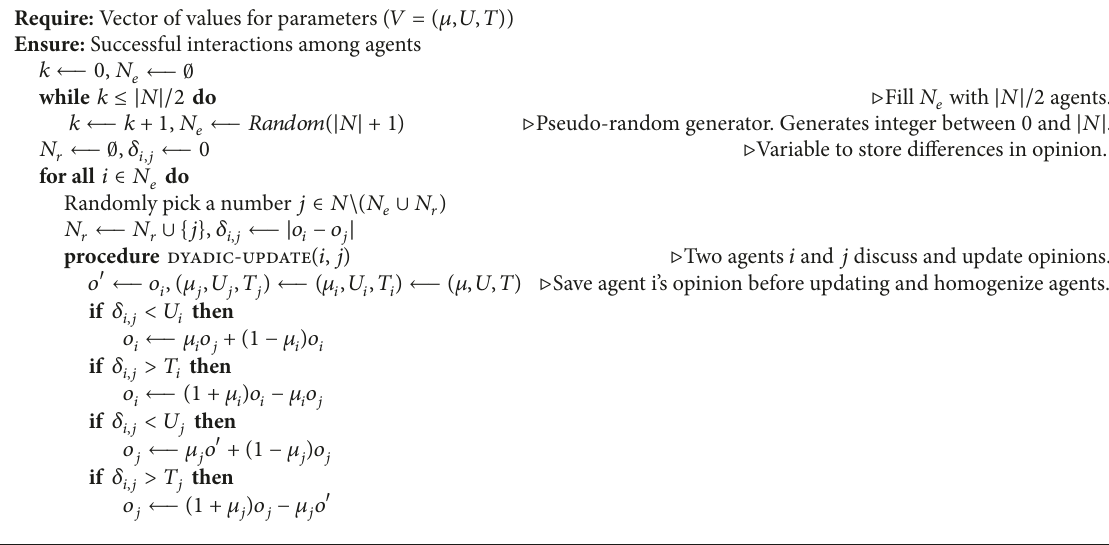
Algorithm 1: Dyadic social influence.